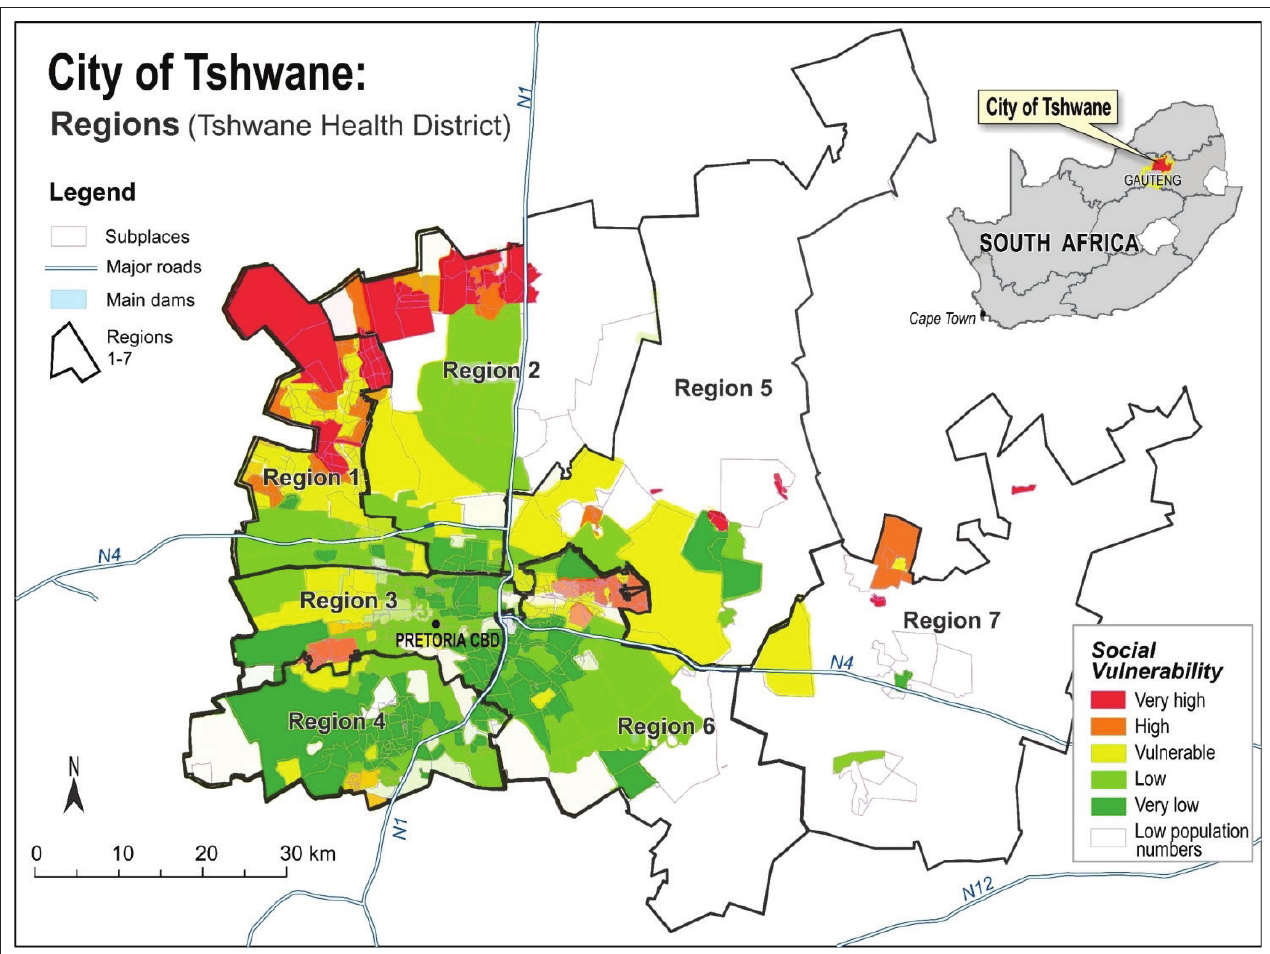
FIGURE 1: Tshwane Health District’s seven subdistricts, portraying the social vulnerability index.